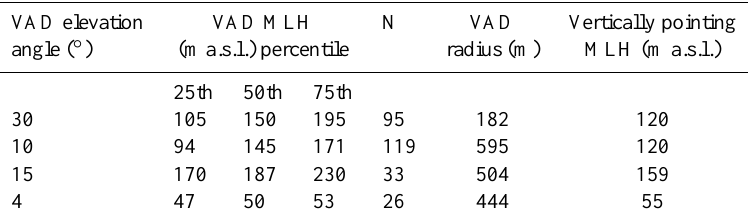
Table 3. Comparison of VAD and vertically pointing MLH estimate. For Limassol data the 25th, 50th and 75th percentile of the VAD-based MLH are presented for the cases when the nearest-neighbour TKE-based MLH is 120ma.s.l. For Loviisa data, the 25th, 50th and 75th percentile of the VAD-based MLH from the 15 ◦ elevation angle VAD are presented for the cases when the nearest-neighbour TKE-based MLH is 159ma.s.l. The 25th, 50th and 75th percentile of the VAD-based MLH from the 4 ◦ elevation angle VAD at Loviisa are presented for the cases when the nearest-neighbour 15 ◦ elevation angle VAD-based MLH is